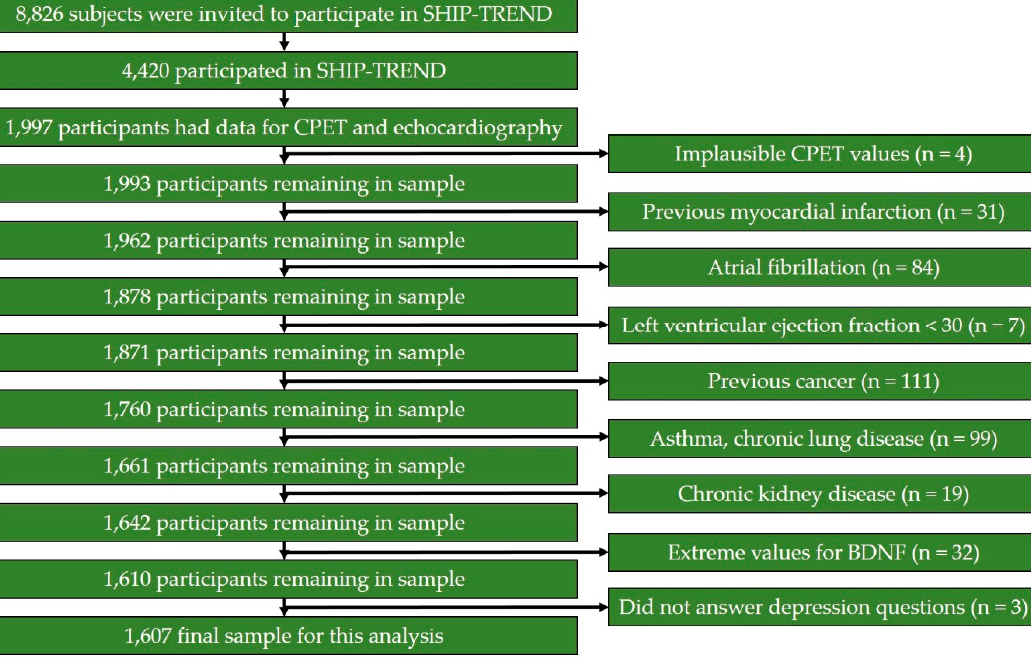
Figure 1. Flow chart of the analysis sample for this investigation was derived. 98